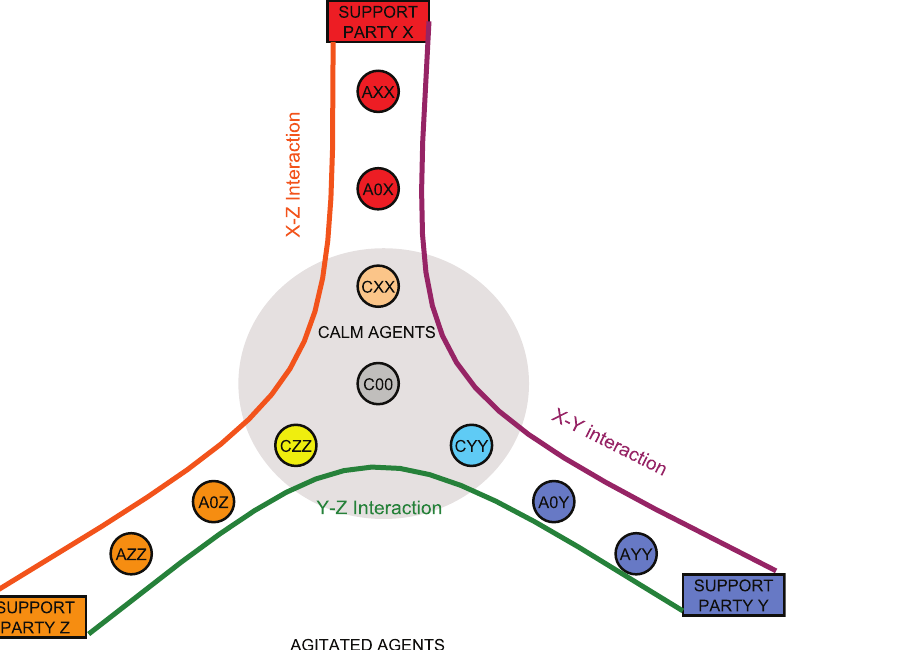
Figure 3. Graphical representation of the three-party model. Any communication between a pair of agents will result in the bipartisan dynamics described in Table 1, and therefore can be described in the seven states of the E/I/O model with the appropriate choice of the two involved parties, for example the case of agent CZZ receiving the message A0Y. The ‘true neutral’ C00 state is common for all interactions. It is therefore possible to derive a multiple-choice dynamics from the binary system introduced in [36].